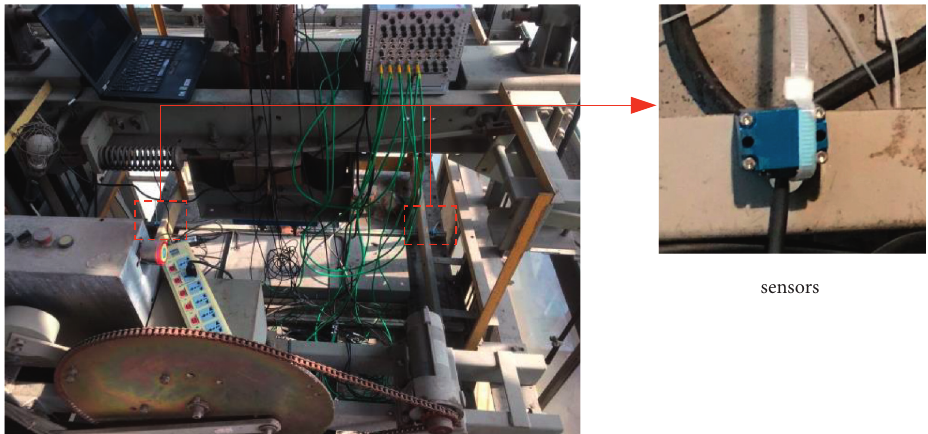
Figure 6: Arrangement of sensors on the